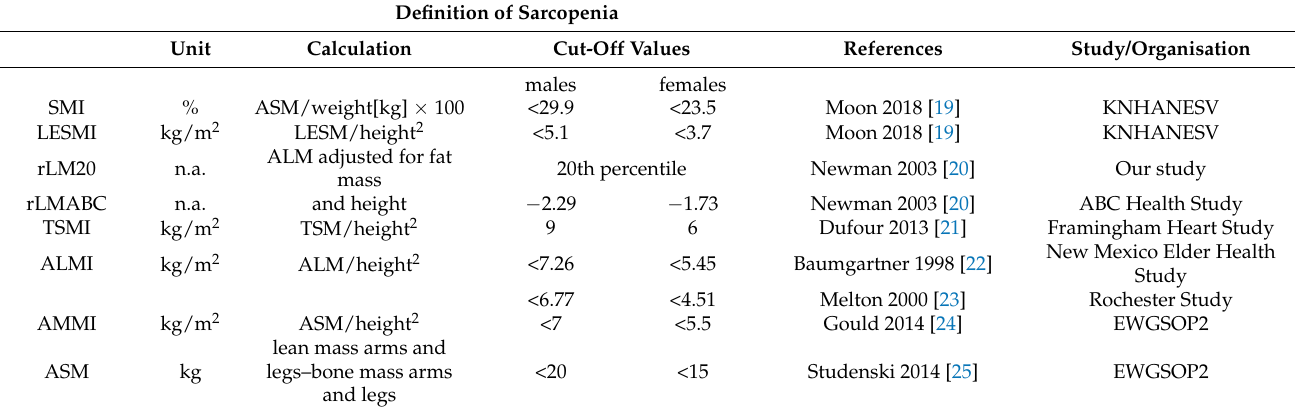
Table 1. Reference values for low muscle mass in